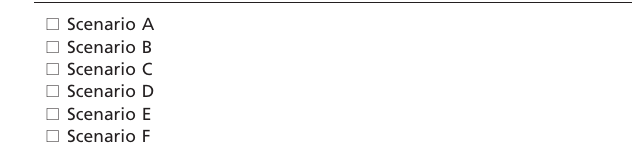
tries to do for the patient is to increase both the lifespan and quality of life. However, imagine that this would not be possible and that you actually would have to choose what you consider to be more